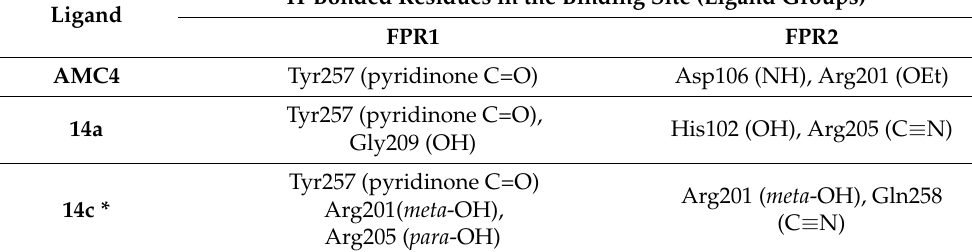
Table 3. Key H-bonding interactions of compounds AMC4 , 14a , and 14c with FPR1 and FPR2 binding sites.